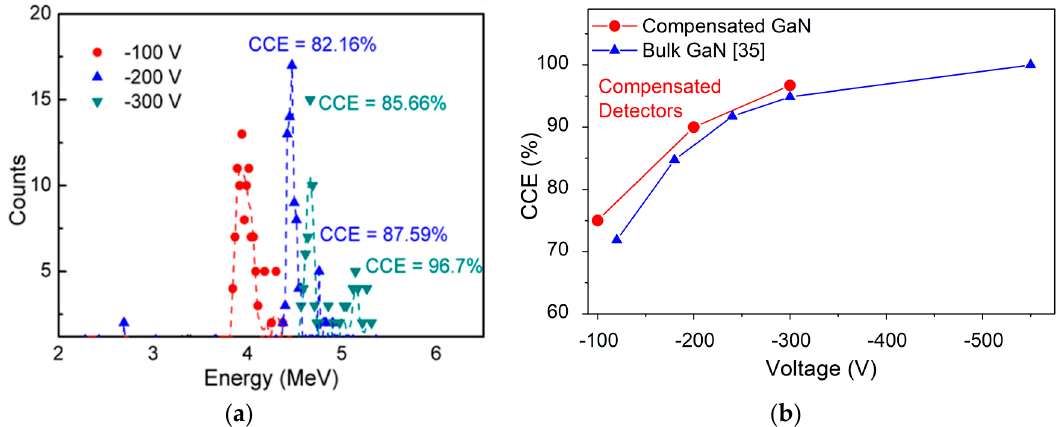
Figure 18. ( a ) α -particle spectra of compensated GaN detectors for different applied voltages (–100 V to –300 V) and ( b ) Comparison of variation in CCE with voltages (–100 V to –550 V) for state-of-the-art α -particle detectors.